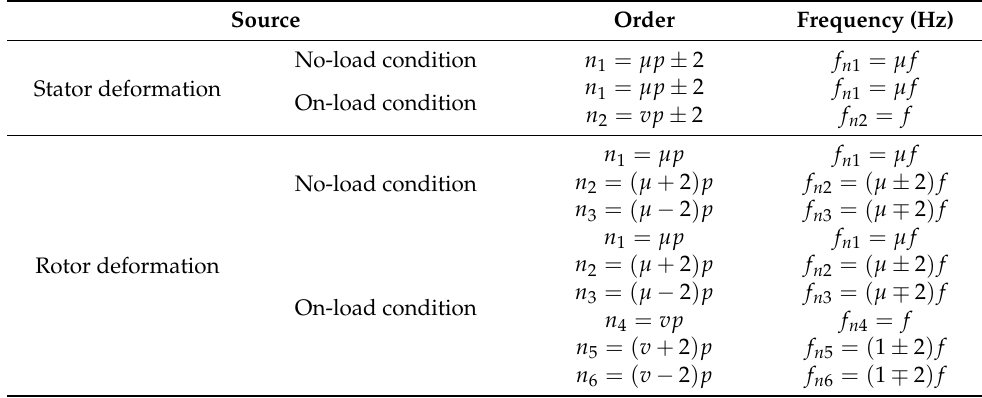
Table 2. Additional contents of magnetic flux density in the